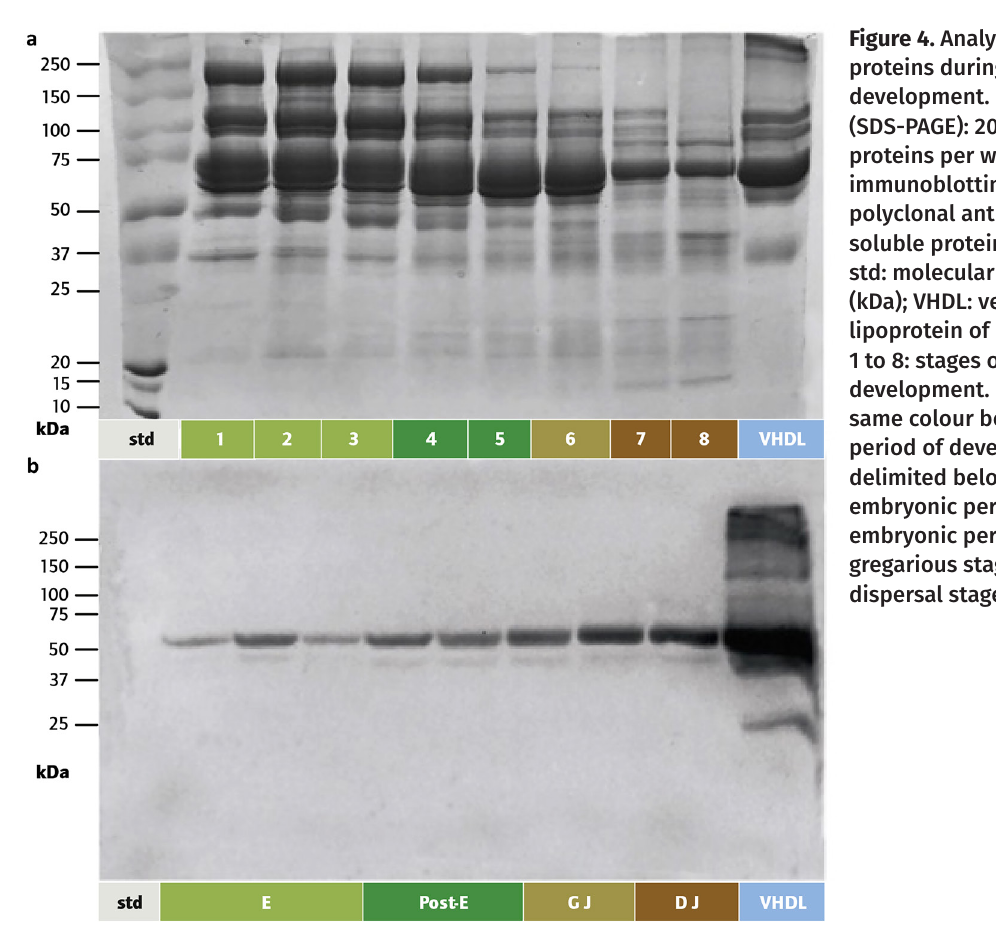
embryonic period; Post-E: post- embryonic period; GJ: juveniles in gregarious stage; DJ: juveniles in dispersal